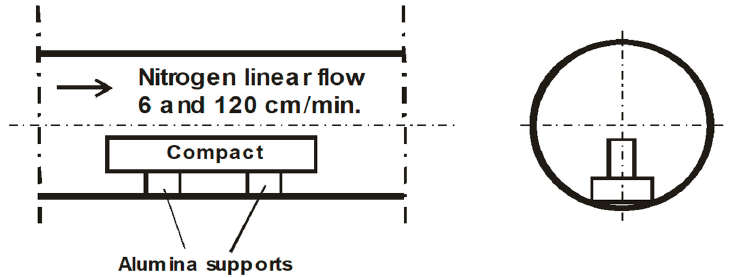
Figure 3. Schematic representation of the compacts’ location in the dilatometer.